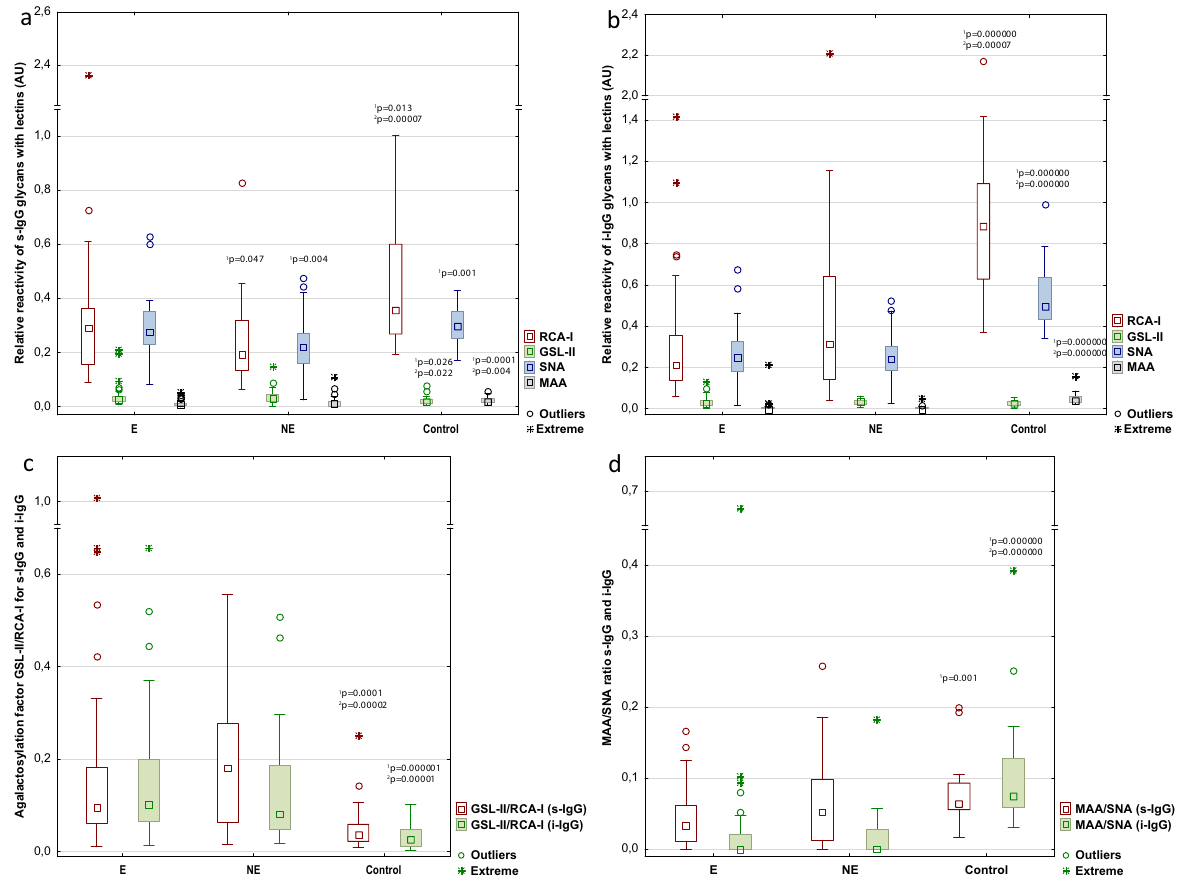
Figure 1. Relative reactivities of serum native IgG (s-IgG)—( a ), and isolated serum IgG (i-IgG)—( b ) glycans with specific lectins. GSL-II: Griffonia simplicifolia lectin II, recognizing terminal GlcNAc; RCA-I: Ricinus communis agglutinin I, recognizing terminal Gal; MAA: Maackia amurensis agglutinin, recognizing sialic acid α2,3-linked; SNA: Sambucus nigra agglutinin, recognizing sialic acid α2,6-linked. E—endometriosis, NE—no endometriosis and Control—group of healthy women. The relative reactivities with lectins were expressed in absorbance units (AU). ( c )—the values of agalactosylation factor GSL-II/RCA-I for IgG glycans. ( d )—the values of MAA/SNA ratio for IgG glycans. MAA: Maackia amurensis agglutinin, recognizing sialic acid α2,3-linked; SNA: Sambucus nigra agglutinin, recognizing sialic acid α2,6-linked. Significant differences versus groups: 1 E, 2 NE. Median is indicated as square. A two-tailed p -value of less than 0.05 was considered as